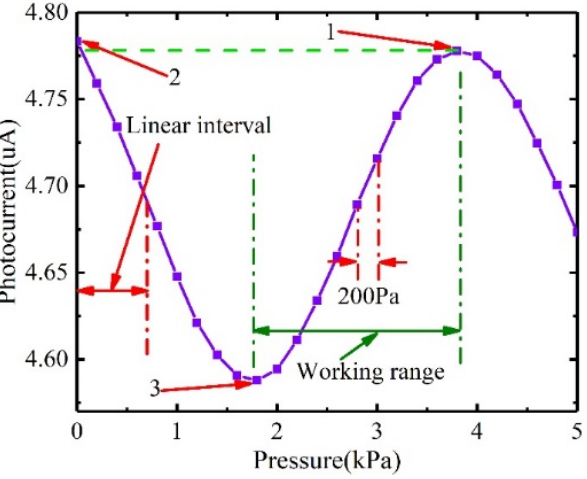
Figure 9. The output photocurrent value of the pressure sensor vs. the loading pressure.